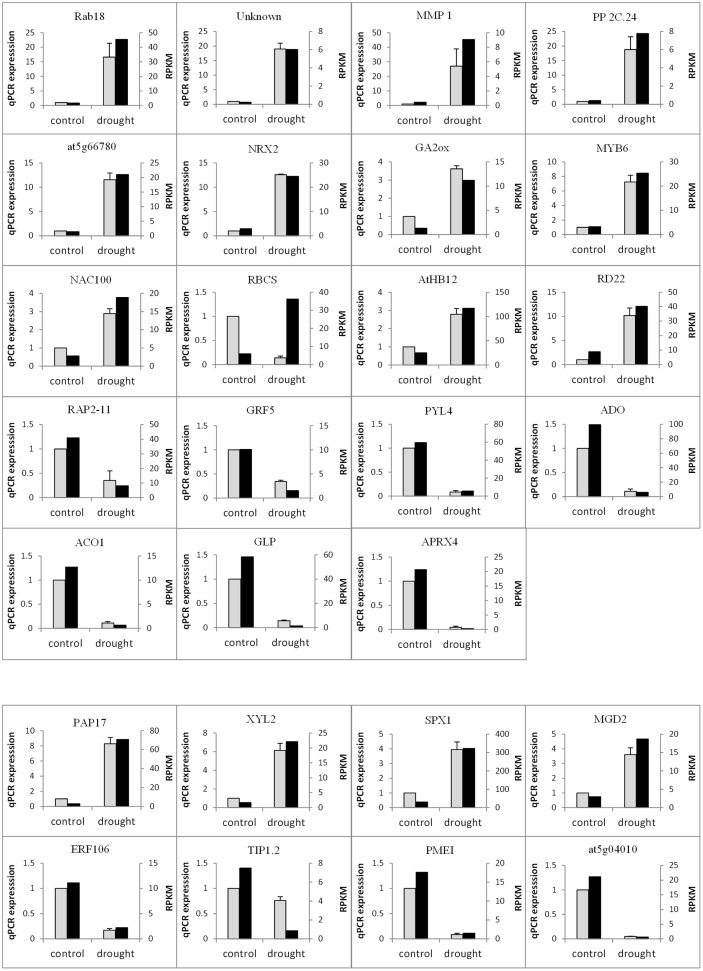
Quantitative reverse transcription polymerase chain reaction (RT-qPCR) validation of selected genes in roots (GF677 rootstock) and leaves (graft, var. Catherina) in the control and drought-stressed plants. The gray bars represent the relative expression determined by RT-qPCR (left y-axis) and the black bars represent the level of expression (RPKM) of the transcripts (right y-axis). The relative expression in the RT-qPCR analysis was normalized to the level in the GF677 rootstock of the control plants. The error bars indicate the standard error of quad-biological and bi-technical replicates. See abbreviations and further information about each gene in Supplementary Table S1.